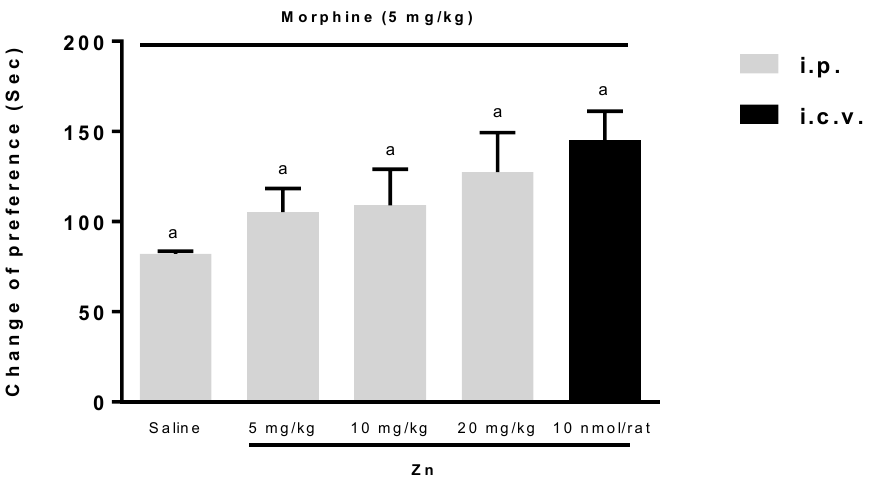
Figure 2. Effects of Zn with morphine on the acquisition (development) of CPP. Zn was given i.p. (5, 10 and 20 mg/kg) and i.c.v. (10 nmol/rat) separately with morphine (5mg/kg) in the conditioning sections in least preferred compartments. Each point represents the mean± SEM of six rats.